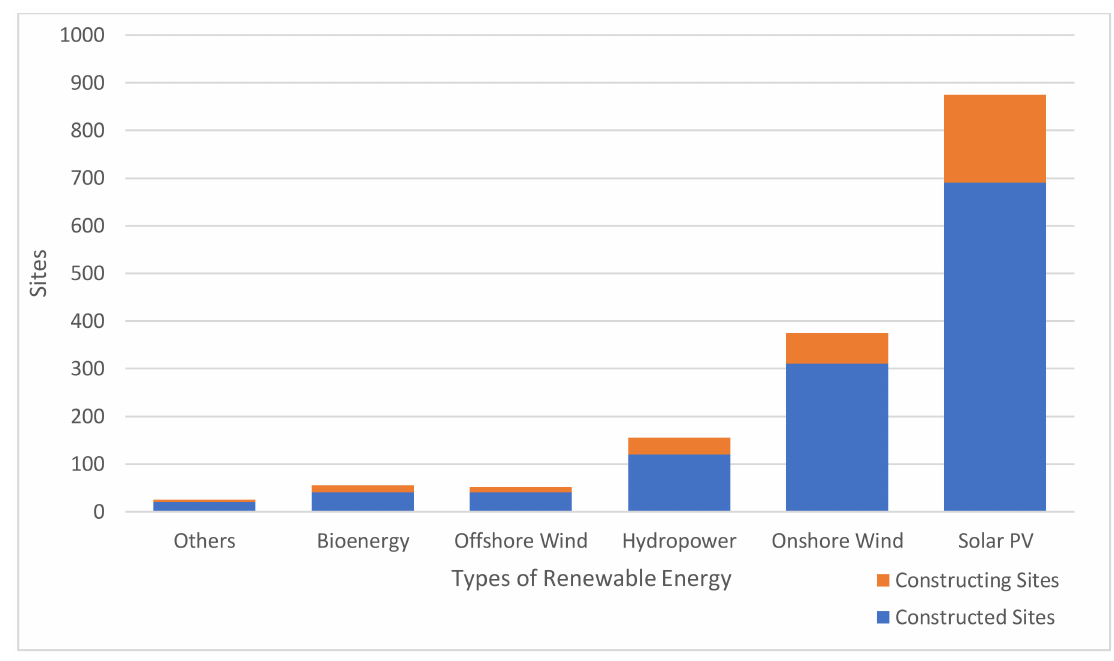
Figure 1. Comparison of di ff erent renewable energy sources [4].